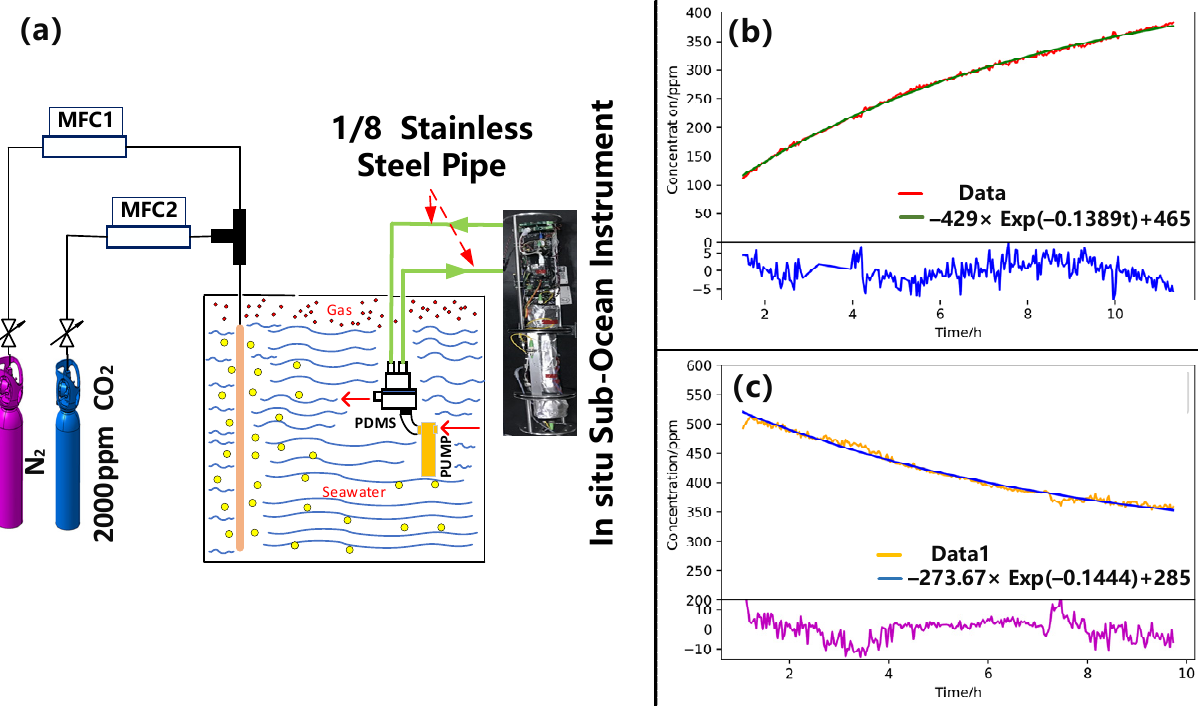
Figure 9. ( a ) Schematic of sample solution preparation and dissolved CO 2 measurement system. Real-time concentration measurements when CO 2 concentration in the cavity is ( b ) lower and ( c ) higher than the dissolved CO 2 , respectively.